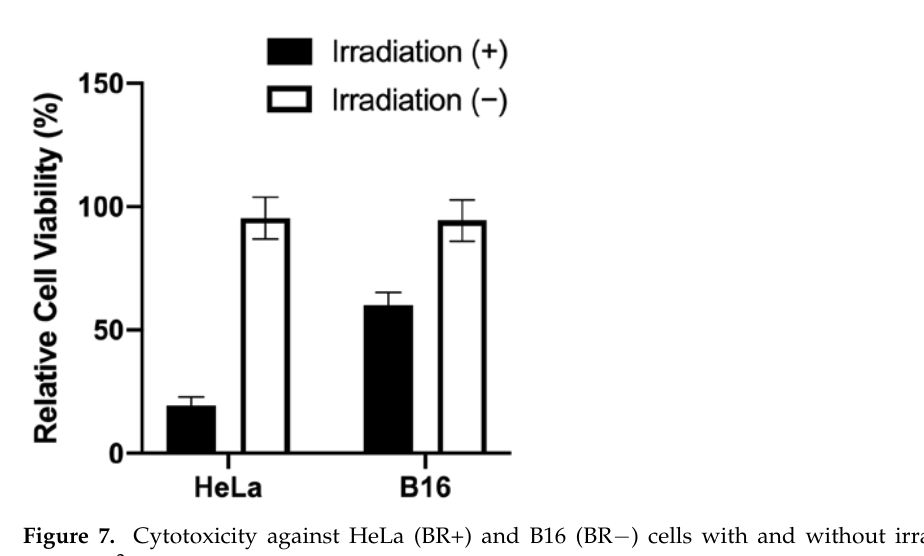
Figure 6. Cytotoxicity against HeLa cells of Ce6 and Ce6-biotin in the dark ( a ) or upon irradiation ( b , λ = 655 nm). p -values < 0.05 are denoted with asterisks (*).